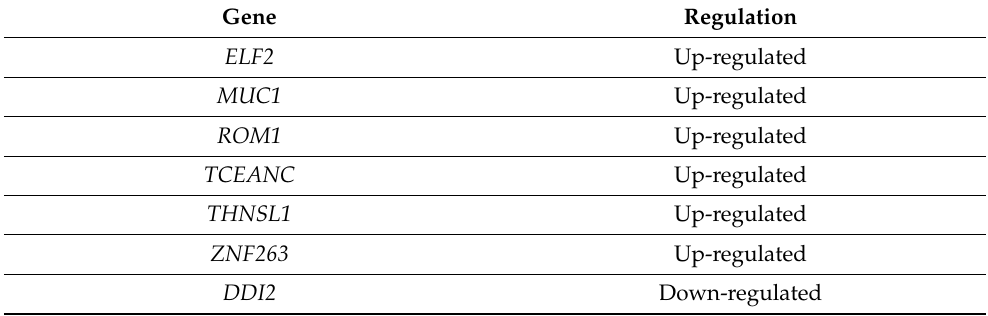
Table 4. List of m6A genes enriched and commonly up- or down-regulated in the two ATC cell lines.